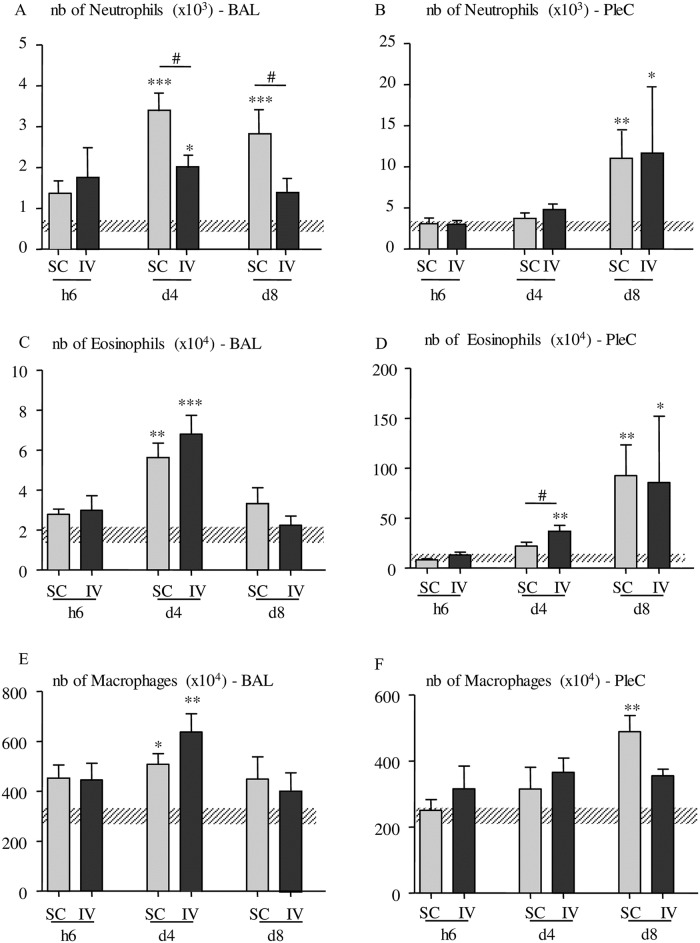
Quantification of macrophages, eosinophils and neutrophils in the bronchoalveolar and pleural spaces.Flow cytometry phenotypic analyses of Ly6G neutrophils (clone 1A8), F4/80 macrophages (clone BM8) and Siglec F eosinophils (clone E50-2440) were performed at different time points (h2, h6, d4 and d8) post inoculation on pleural cells (PleC) or cells isolated from broncho-alveolar lavage (BAL) from IV- and SC-infected mice. (A-B) Number (nb) of F4/80+ macrophages in the broncho-alveolar lavage (A) and in the pleural cells (B); (C-D) Number of Siglec F+ eosinophils in broncho-alveolar lavage (C) and in the pleural cells (D);.(E-F) Number of Ly6G+ neutrophils in the broncho-alveolar lavage (E) and in the pleural cells (F). Number of cells in uninfected mice are represented by a dashed horizontal bar. The results are expressed as mean ± SEM, n = 4–6, Kruskal-Wallis followed by a Dunns (*p<0.05. **p<0.01, ***p<0.001 between infected and naive mice, #p<0.05 difference between SC- and IV-infected mice for a given time point).